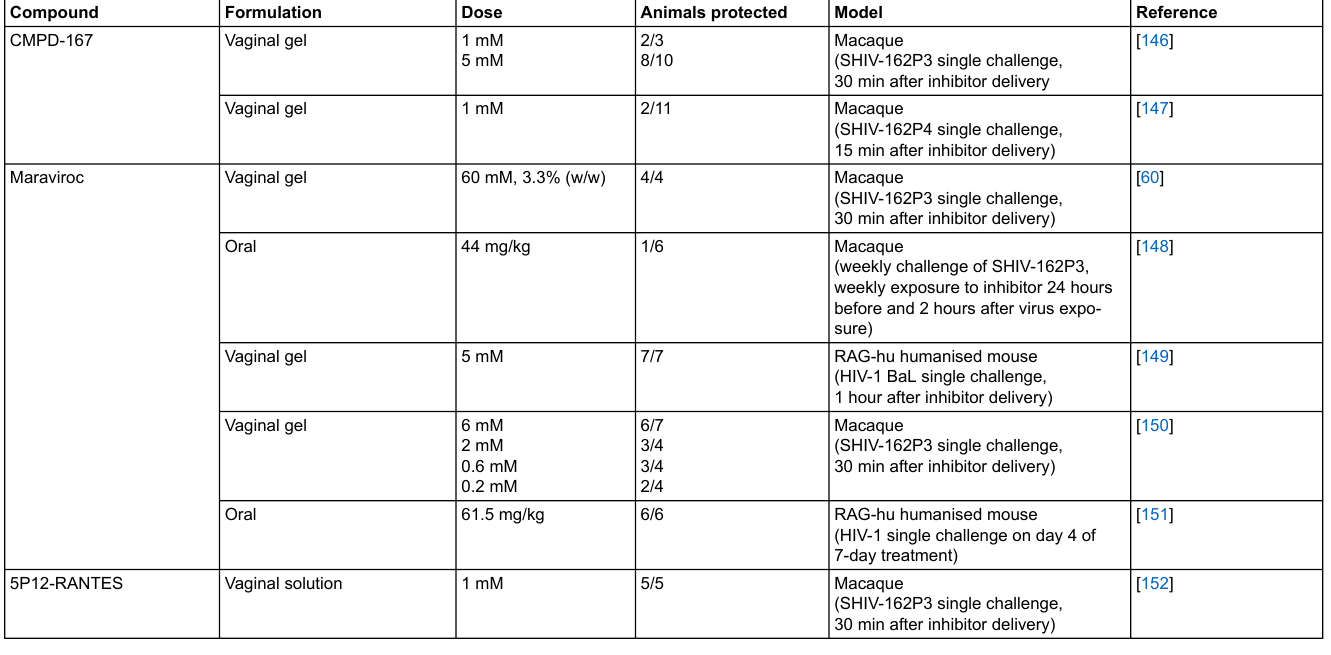
Table 1: Preclinical efficacy testing of CCR5 inhibitors in animal models of HIV transmission. Compound